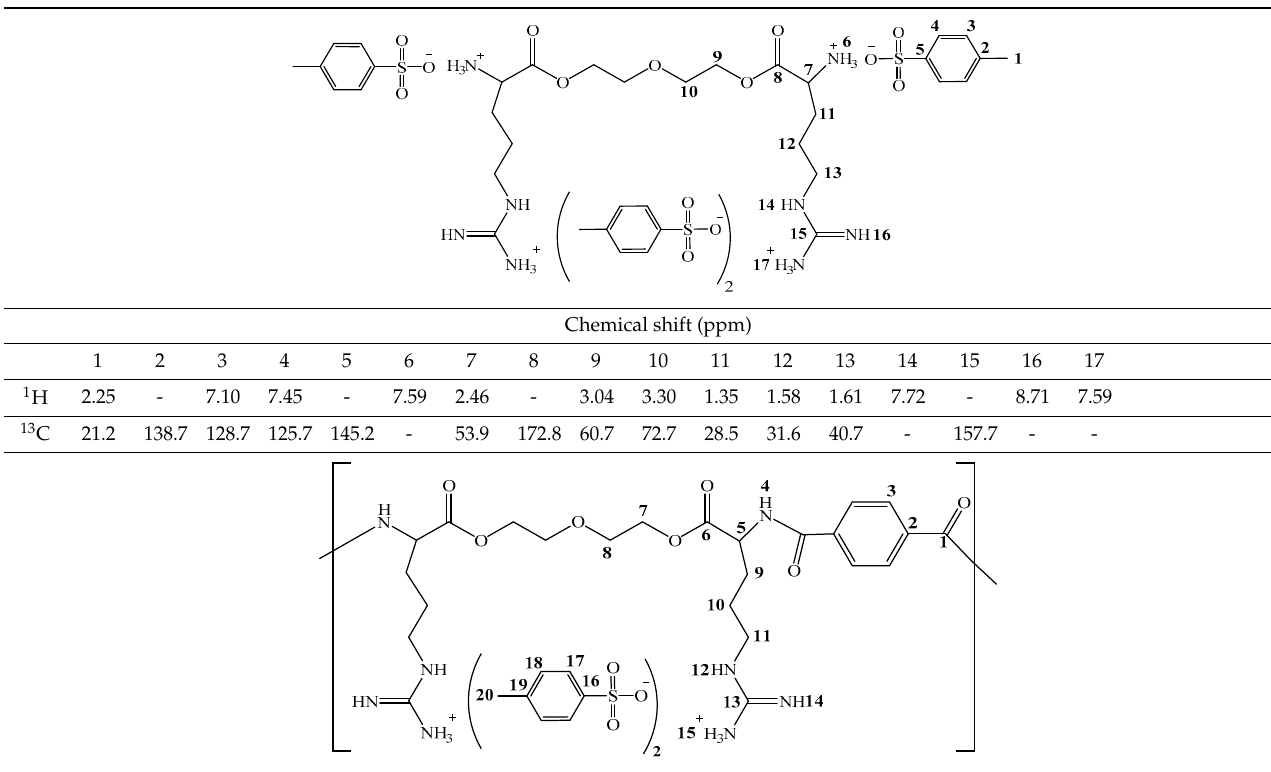
Figure 5. ( a ) 1 H NMR of di- p -toluenesulfonic acid salt of O,O’-bis-(L-arginine)-diethylene glycol monomer (experiments were recorded at 500 MHz). ( b ) 1 H NMR of poly(ester amide) based on L-arginine. ( c ) 13 C NMR of di- p -toluenesulfonic acid salt of O,O’-bis-(L-arginine)-diethylene glycol monomer. ( d ) 13 C NMR poly (ester amide) based on L-arginine. Experiments were recorded at 125 MHz. Table 2. 1 H NMR and 13 C NMR data of the synthesized monomer and polymer.